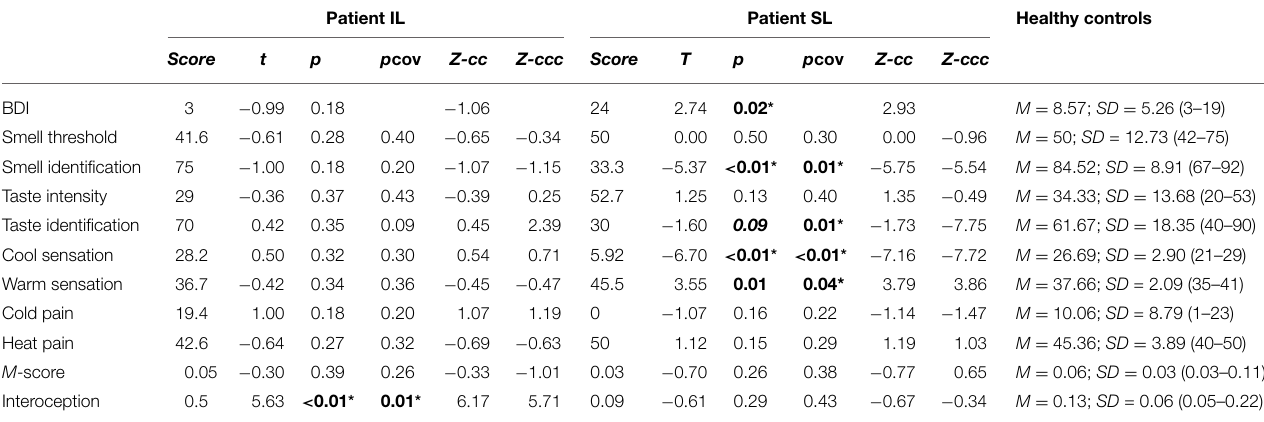
TABLE 2 | Results of comparing patient IL and SL with healthy age-matched controls.